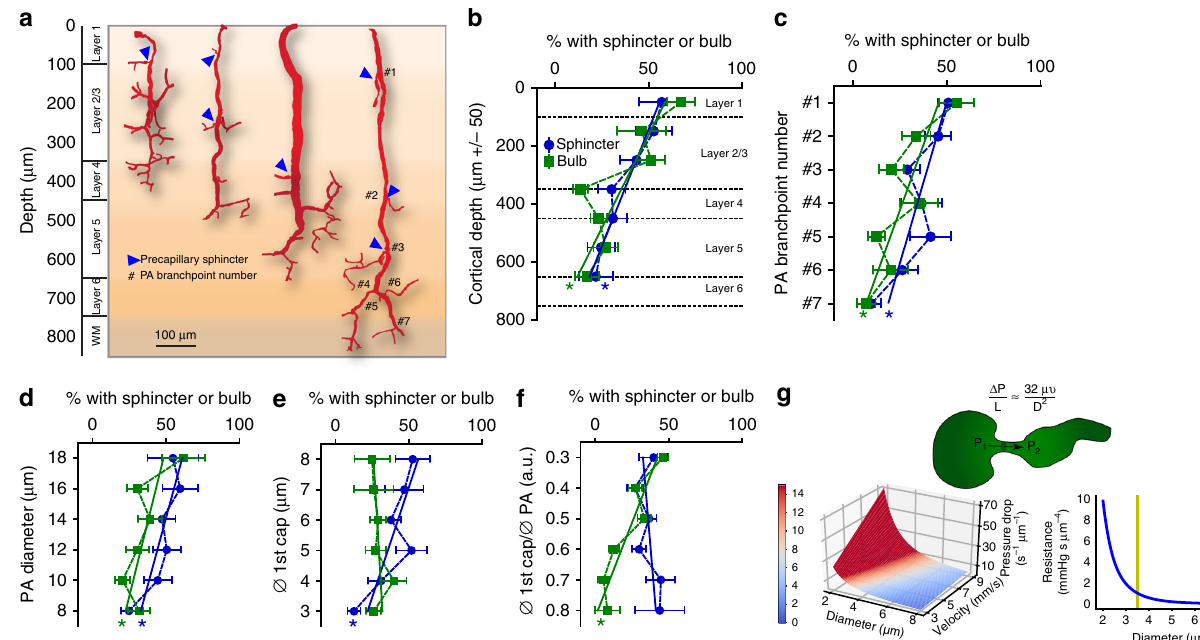
Fig. 2 Location of sphincters help pressure equalization along PA. a Representatives of four PA subtypes reaching different cortical layers based on ex vivo data. Precapillary sphincters are found at varying depths (marked by blue arrowheads and branchpoint numbers are indicated on the right PA). b – f Dependency of the presence and location of precapillary sphincters and bulbs (binned quanti fi cation) on various parameters. Criteria for the positive presence of sphincter or bulb at a branch point: sphincter <0.8 and bulb >1.25 times the diameter of a fi rst order capillary, in total 602 branchpoints of 108 PAs in 9 mice were analyzed, ±SEM, linear regression, * = slope deviates signi fi cantly from 0. b Dependency on cortical depth (bin size 100 µ m). c Dependency on PA branch number (counting from the proximal end). d Dependency on PA diameter (bin size 2 µ m). e Dependency on fi rst order capillary diameter (bin size 1 µ m). f Dependency on fi rst order capillary/PA diameter ratios (bin sizes as in d and e ). g Top panel: Illustration of a pressure decrease across a precapillary sphincter and modi fi ed expression of Poiseuille ’ s law. Δ P is the pressure difference, L unit length, µ viscosity, and υ fl ow velocity. Lower left: Illustration of Poiseuille ’ s law showing how the pressure drop (de fi ned as pressure difference per unit length times viscosity, Δ P μ L , also unit of color scale), depends on the cylindrical lumen diameter and fl ow velocity. Note how the pressure drop increases with lumen diameters below 4 µ m. Lower right: Combining fl ow resistance in laminar fl uid fl ow with Poiseuille ’ s law yields an equivalent representation of how fl ow resistance (de fi ned as resistance per unit length and viscosity, R μ L ) depends on lumen diameter. Source data are provided as a Source Data fi